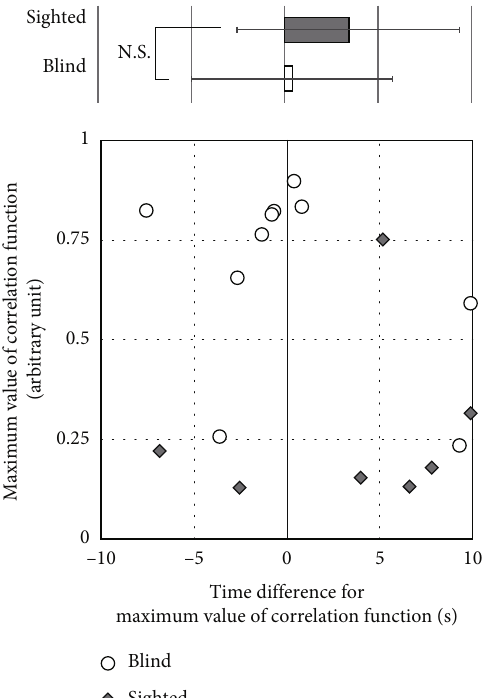
Figure 5: Distribution of the “ time di ff erence for the maximum correlation function ” and the “ maximum correlation function. ” The horizontal bar graph above the distribution graph shows the average and standard deviations of “ the time di ff erences for the maximum correlation function.